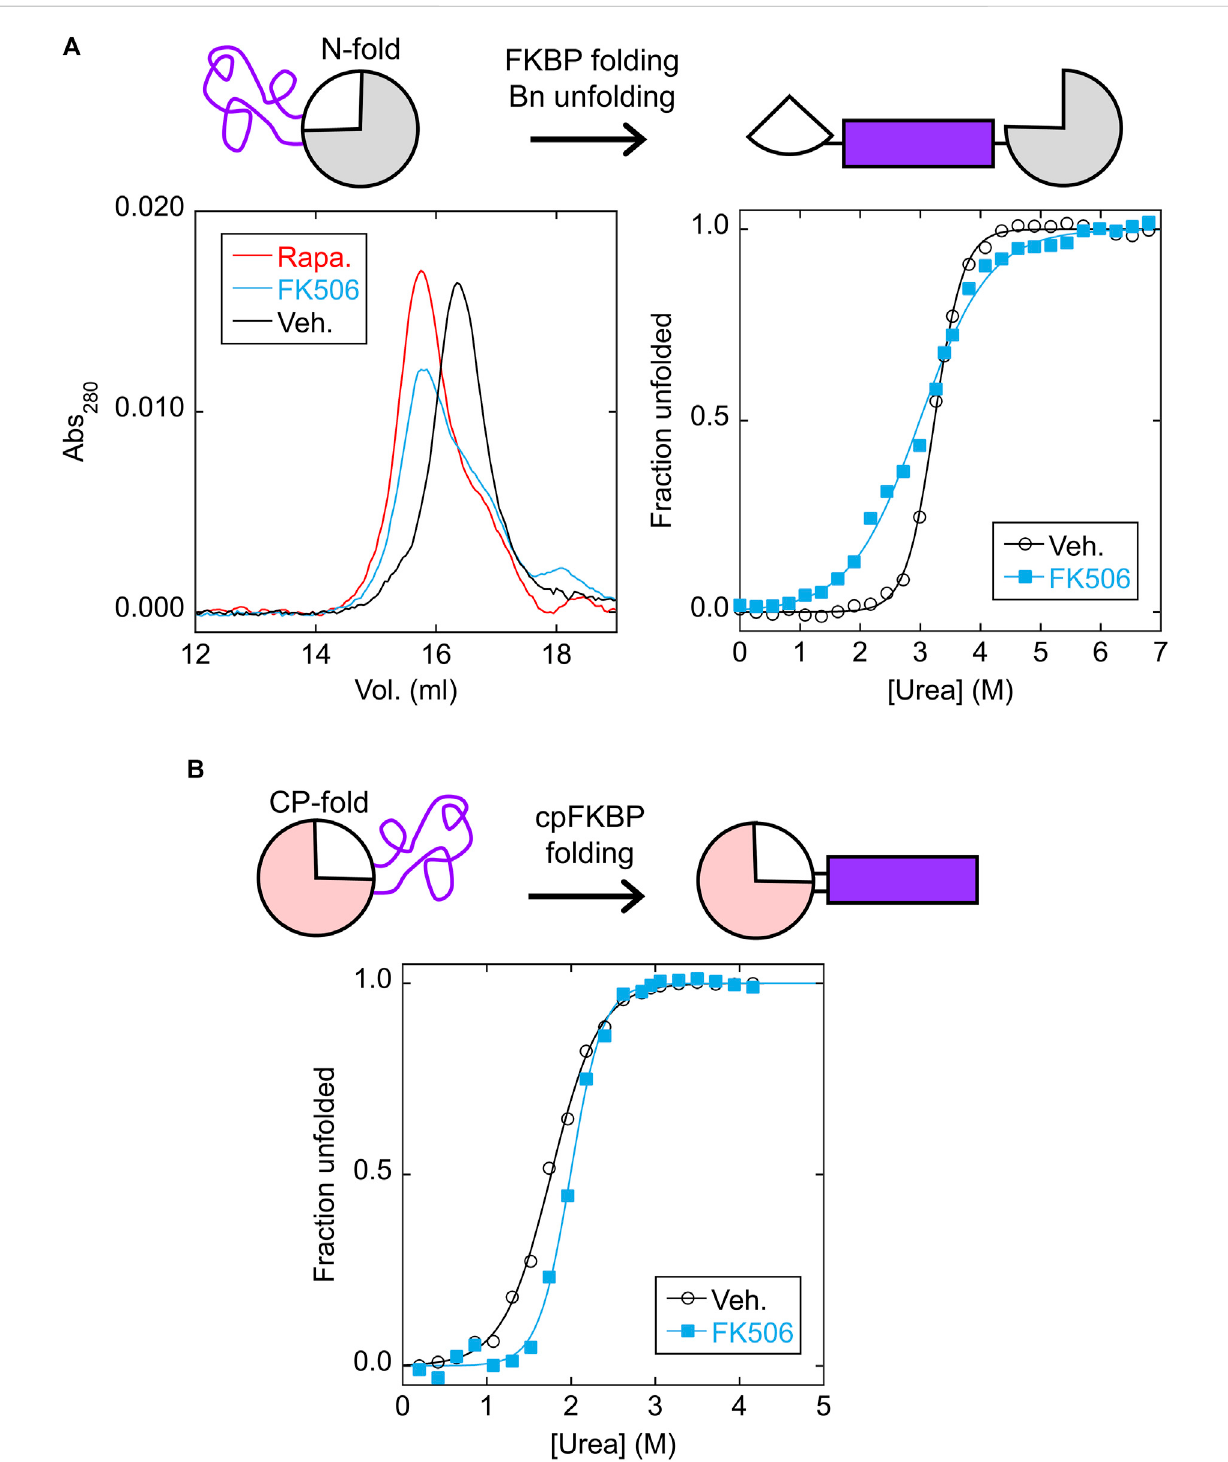
FIGURE 3 FKBP folding destabilizes the N-fold analog via MEF, and cpFKBP folding stabilizes the CP-fold analog via LCE. (A) SEC chromatograms (left) found that the N-fold analog eluted at a higher apparent MW in the presence of rapamycin or FK506, suggesting that binding to the FKBP domain destabilized and at least partially unfolded the Bn domain. Δ G unfold and C m values (Supplementary Table S1) obtained from urea denaturation curves (right) supported this conclusion. (B) Urea denaturation curves of the CP-fold analog found that FK506 binding increased Δ G unfold and C m (Supplementary Table S1), consistent with removal of the loop-closure entropy penalty imposed by the unfolded cpFKBP domain. Each point is an average of three technical repeats. Raw data are plotted in Supplementary Figure